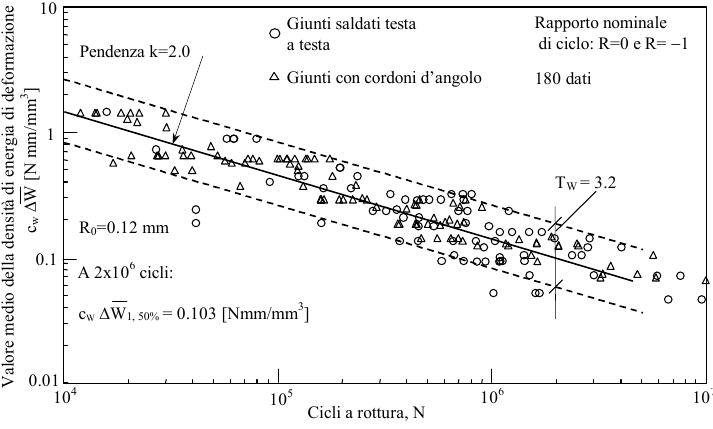
Figura 8: Resistenza a fatica di giunti saldati testa a testa e di giunti con cordone d’angolo in lega leggera in funzione del valore medio della densità di energia di deformazione [12,20]; banda di dispersione tratta dalla referenza [12].